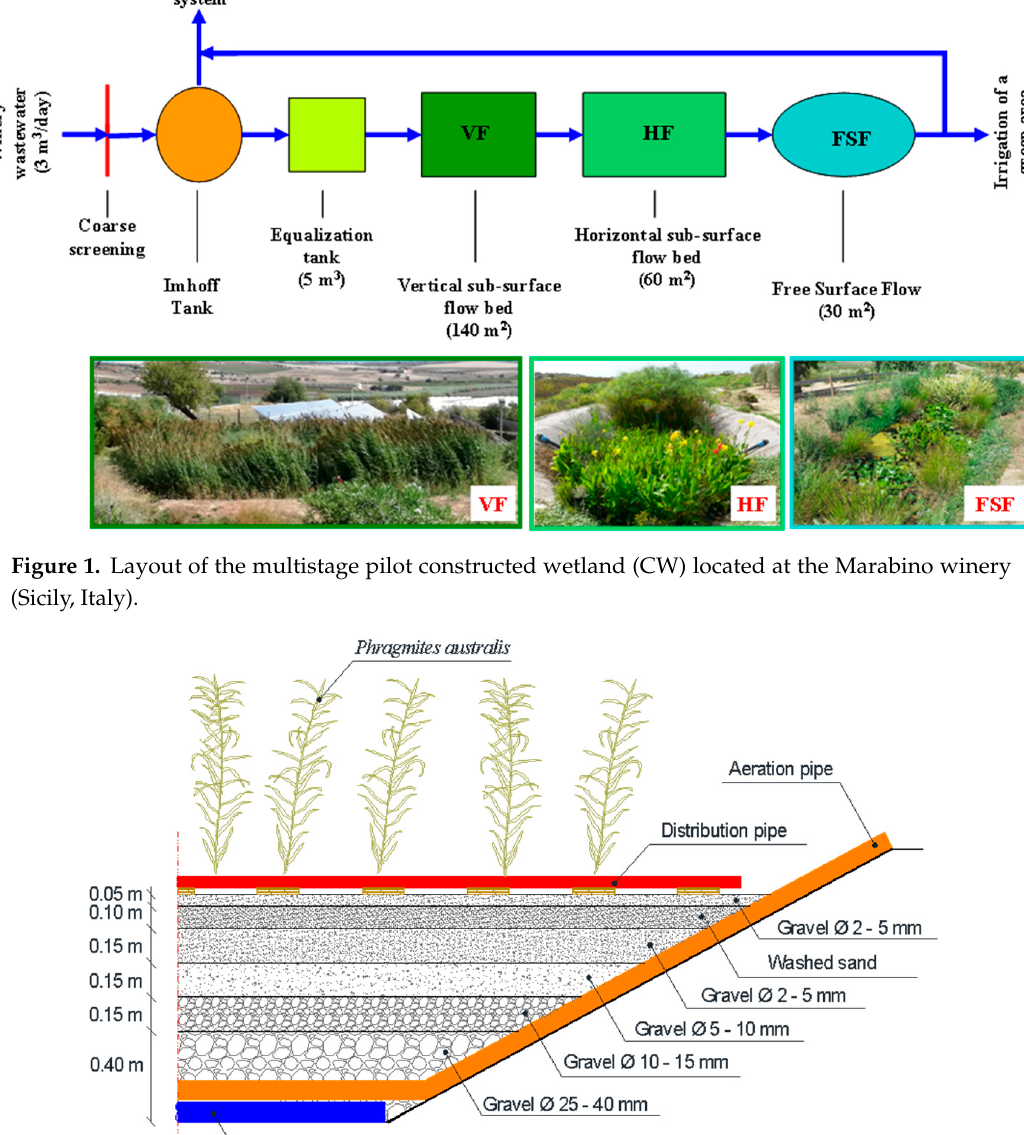
Figure 1. Layout of the multistage pilot constructed wetland (CW) located at the Marabino winery (Sicily, Italy).